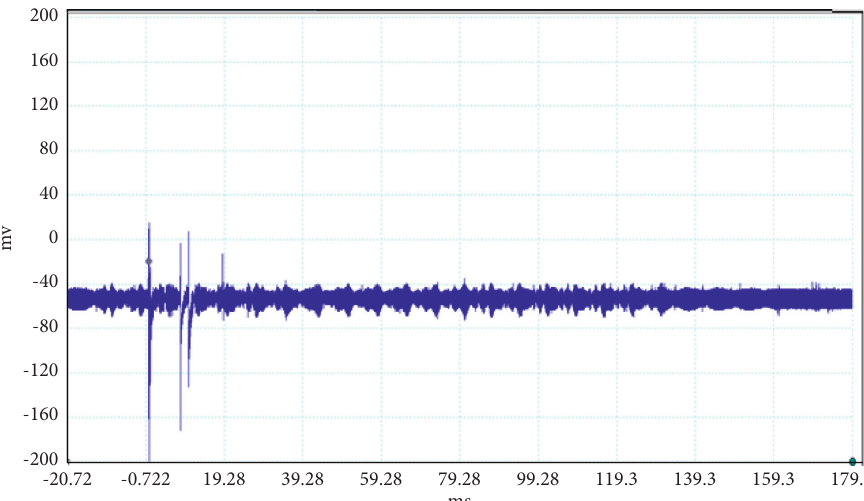
Figure 3: Example of the unusual lightning signal of window size 200ms, which is recorded as a flash number 20150416-0004 in Kathmandu, Nepal.